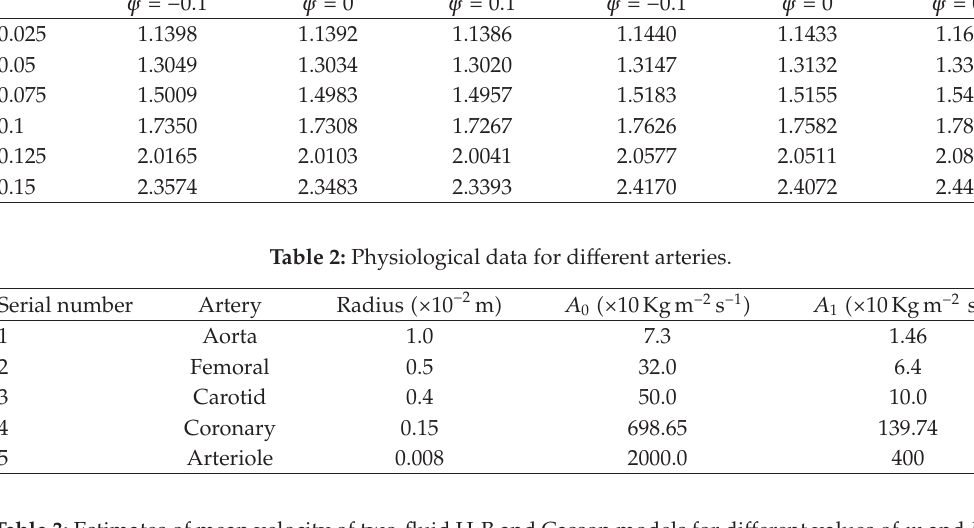
Table 3: Estimates of mean velocity of two-fluid H-B and Casson models for di ff erent values of m and B in arteries with di ff erent radii with t (cid:7) 60 ◦ , β (cid:7) n (cid:7) 0 . 95, θ (cid:7) δ P (cid:7) 0 . 1, φ (cid:7) α (cid:7) α H (cid:7) α C (cid:7) 0 . 2, z (cid:7) 2 . 3, e (cid:7) 0 . 5, ω (cid:7) 1, and b (cid:7) 0 .